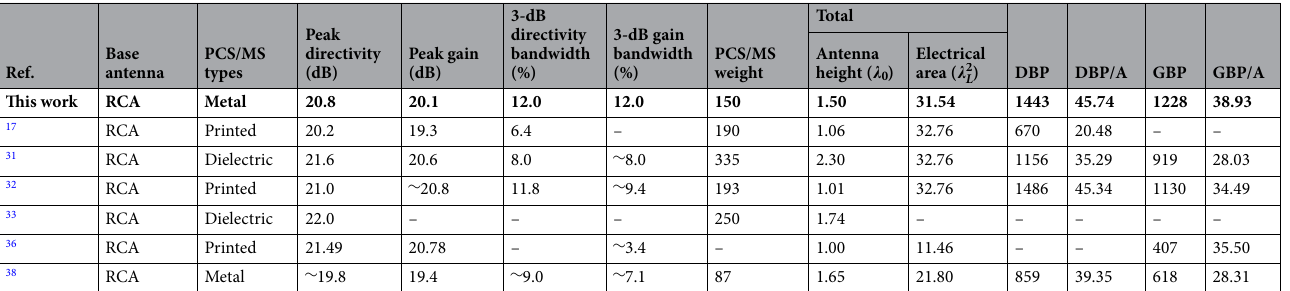
Table 3. Comparison of measured performance with recently reported PCS/metasurface (MS) based RCA designs. ‘–’ values are not available in the literature. ‘ ∼ ’ estimated from the wideband graphs in the literature.